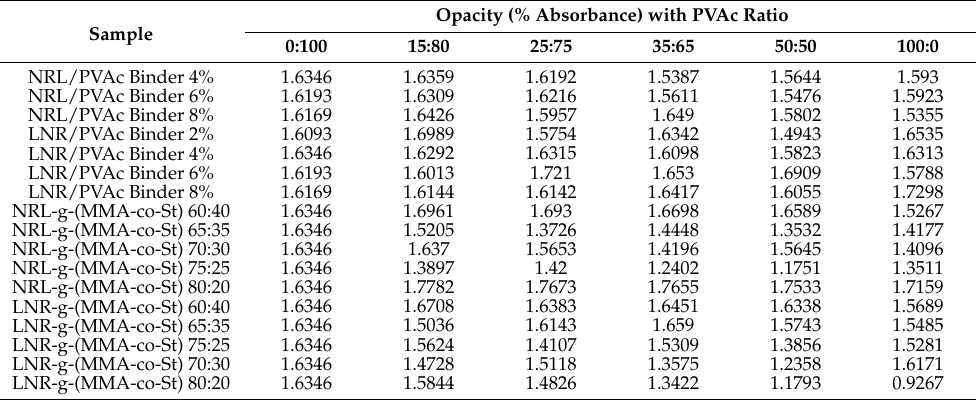
Table 2. Opacity properties of emulsion paints on various binder